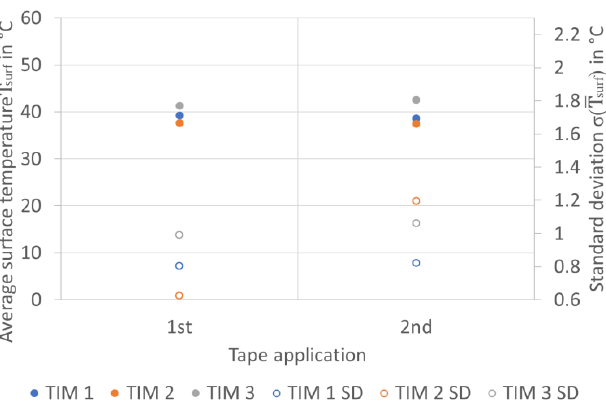
Figure 15. Variation of the measured values depending on the tape application.